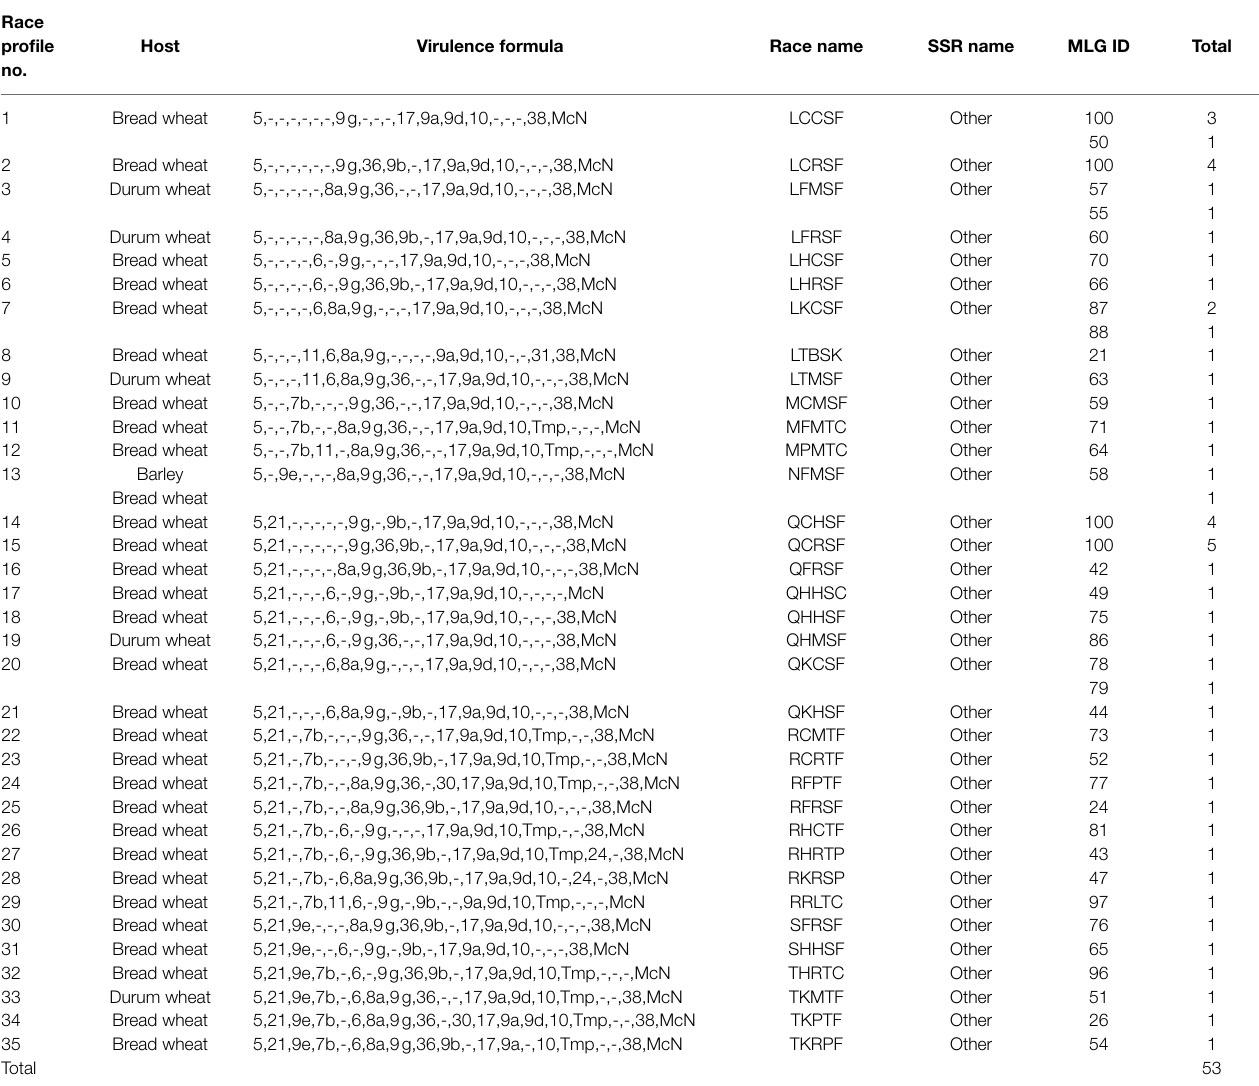
TABLE 7 | Virulence diversity of 35 races of P. graminis f.sp. tritici in Russia 2016–2017. Race